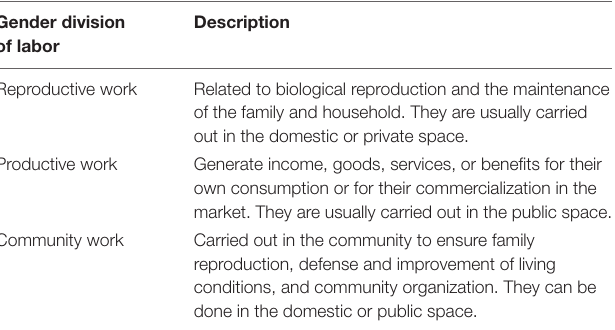
TABLE 2 | Description of the gender division of labor according to Aguilar and Castañeda (2001). Gender division of labor